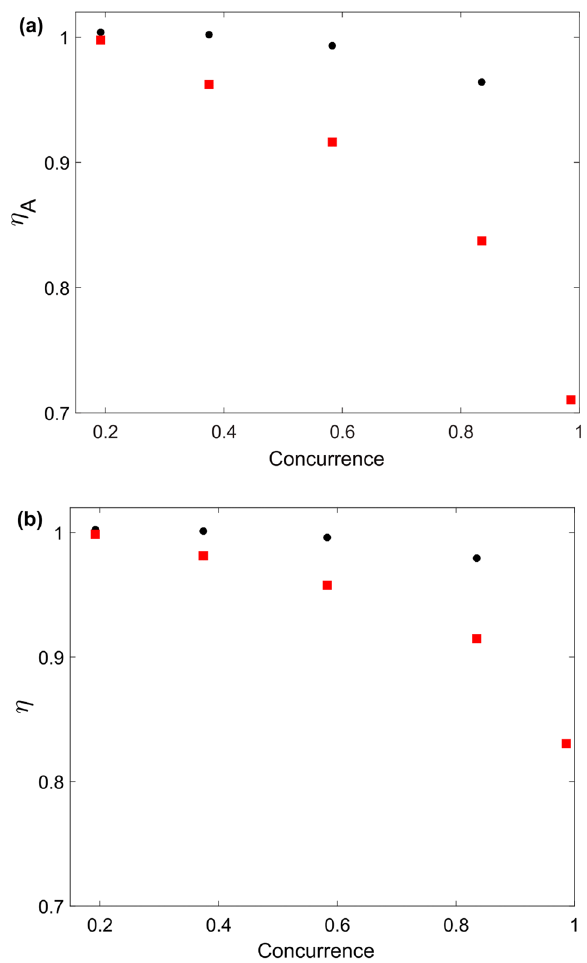
Figure 2. Minimum efficiencies required to close the loophole for the ( a ) Asymmetric case, where η B = 1 , and ( b ) Symmetric case, where η A = η B = η . We compare efficiencies associated with the tilted Bell inequality [black circles] and the optimization proposed in (6) [red squares]. In both cases, we consider the optimal experimental data obtained for the tilted inequality (9). Figures created on Python 3.8.8, https:// www. python.